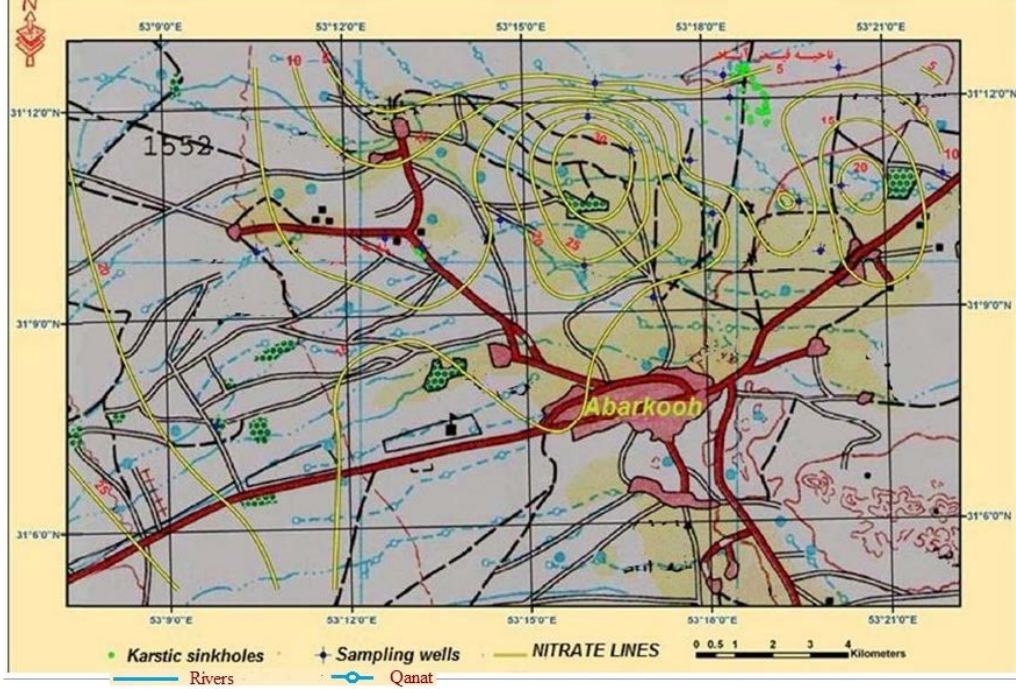
Figure 13. Contour lines of the nitrate concentrations in groundwater in mg/L in the Abarkooh plain.